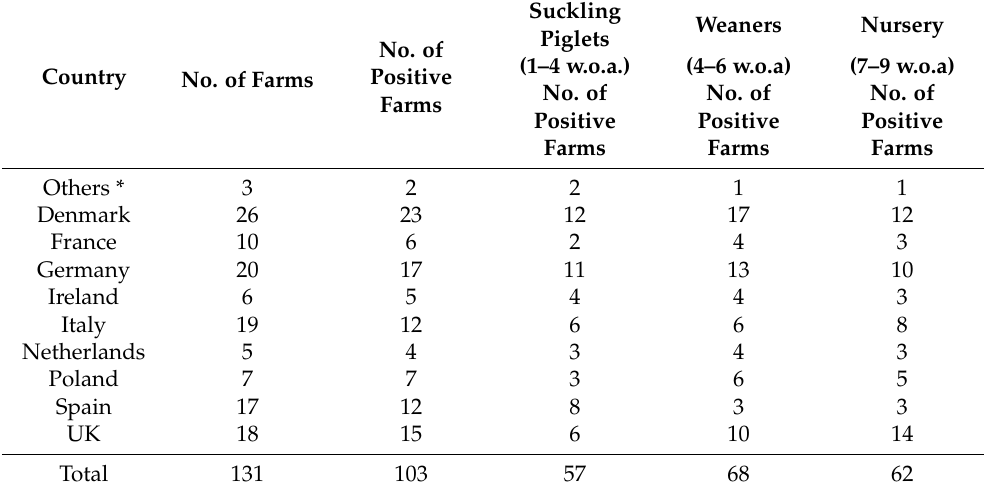
Table 1. Detection of IAV by RT-PCR at the farm level in the different countries and sampled age